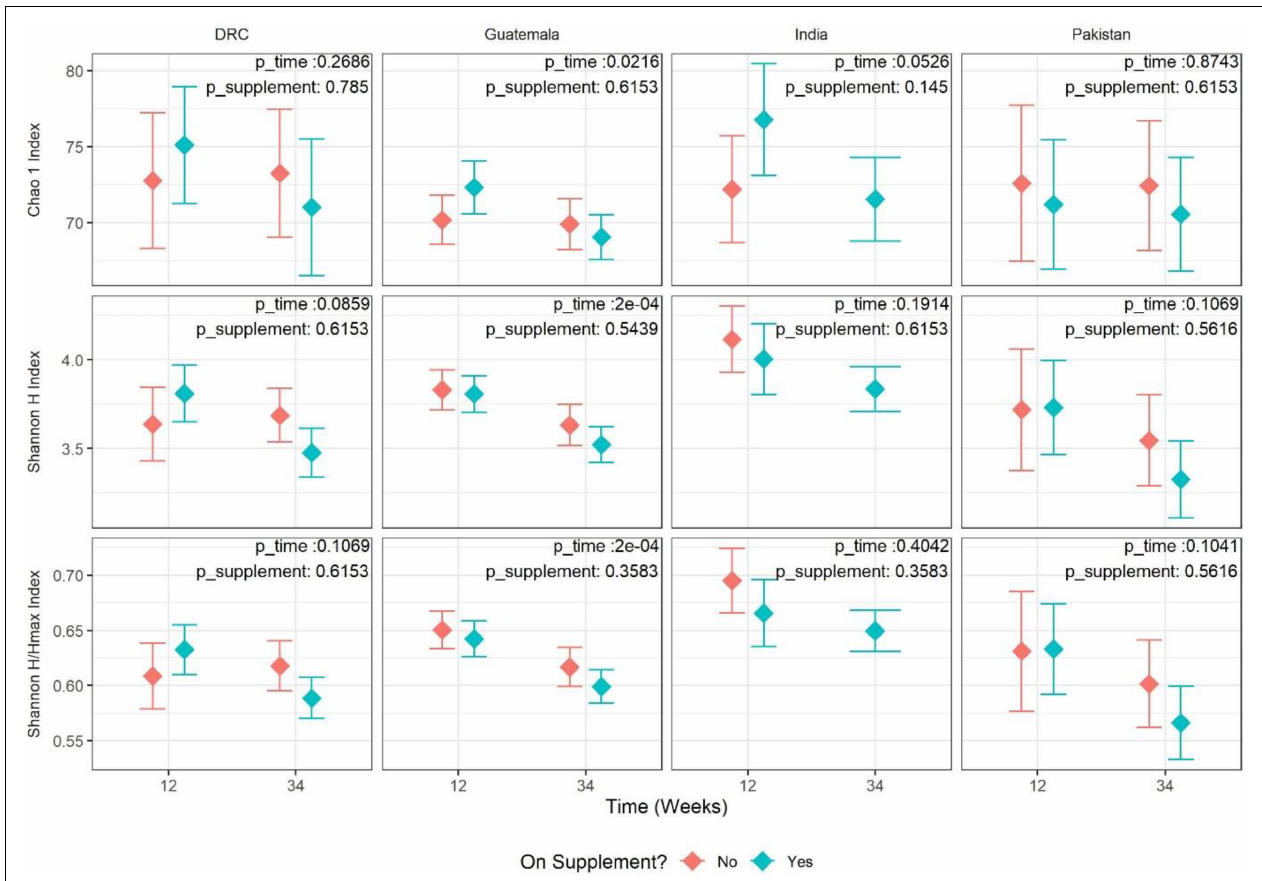
FIGURE 1 | Adjusted mean estimate for alpha-diversity values by site and time (12 vs. 34 weeks). Each panel represents one pairing of site and alpha-diversity measure [eveness, richness, and Shannon diversity (richness and eveness)]. Each value is the adjusted mean estimate from the GEE model (diamond point) and 95% CI (error bars) for the respective measure of alpha-diversity split by time point and supplement status. Supplement status “Yes” indicates Arm 1 at 12 weeks and Arms 1+2 at 34 weeks. Supplement status “No” indicates Arm 2 at 12 weeks and Arm 3 at 34 weeks. The corresponding p -values for tests of time and supplement status are overlayed in the top-right corner of each